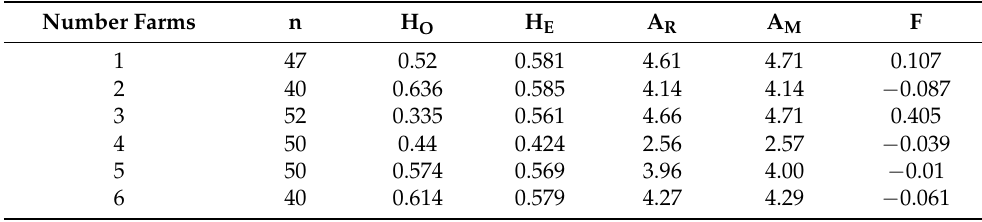
Table 9. Characteristics of sheep of the Romanov breed from various regions of the Russian Federation (n = 576).